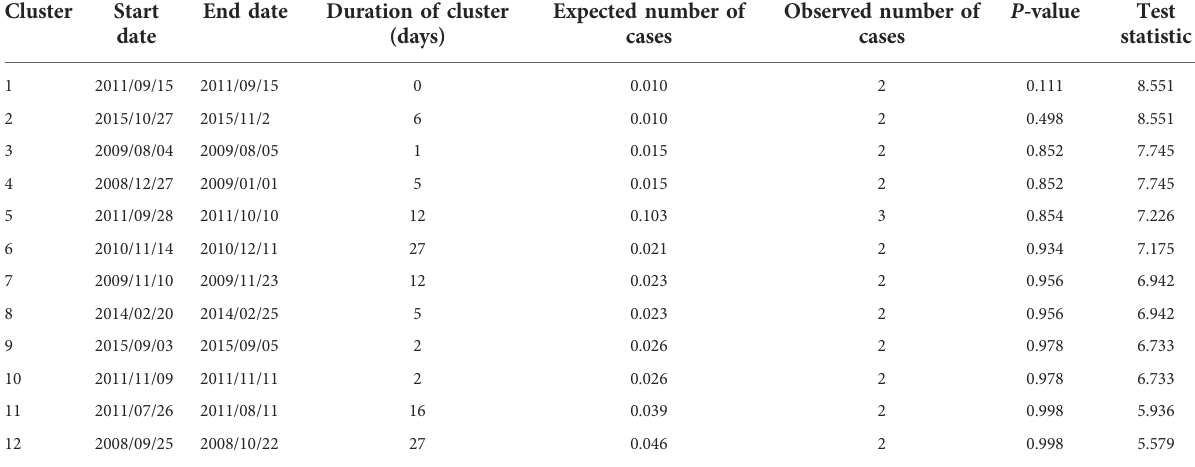
TABLE 1 Clusters detected during the period 2008 – 2017 in County Cork.